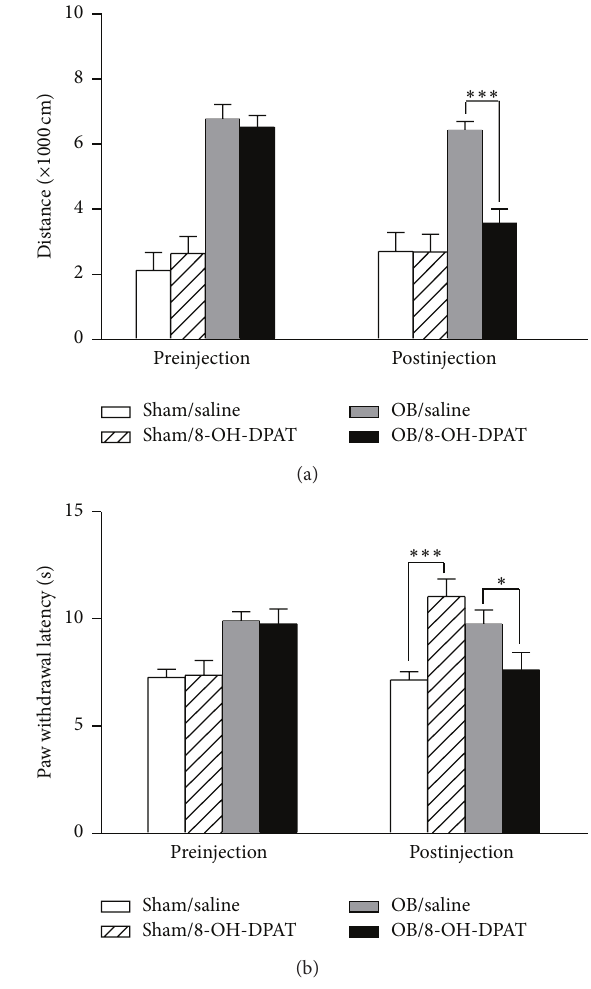
Figure 4: Effects of chronic administration of 8-OH-DPAT. (a) Locomotor activity in the open-field. Chronic 8-OH-DPAT treat- ment had no effect on the sham rats but significantly reduced the locomotor activity in the OB rats ( 𝑛 = 8 – 12 ). (b) Radiant heat pain threshold. Pain thresholds in the sham rats were increased after the treatment; by contrast, those in the OB rats were decreased and restored to normal level ( 𝑛 = 8 – 12 ). Data are presented as mean ± SEM. ∗ 𝑃 < 0 .05, ∗∗∗ 𝑃 < 0.001